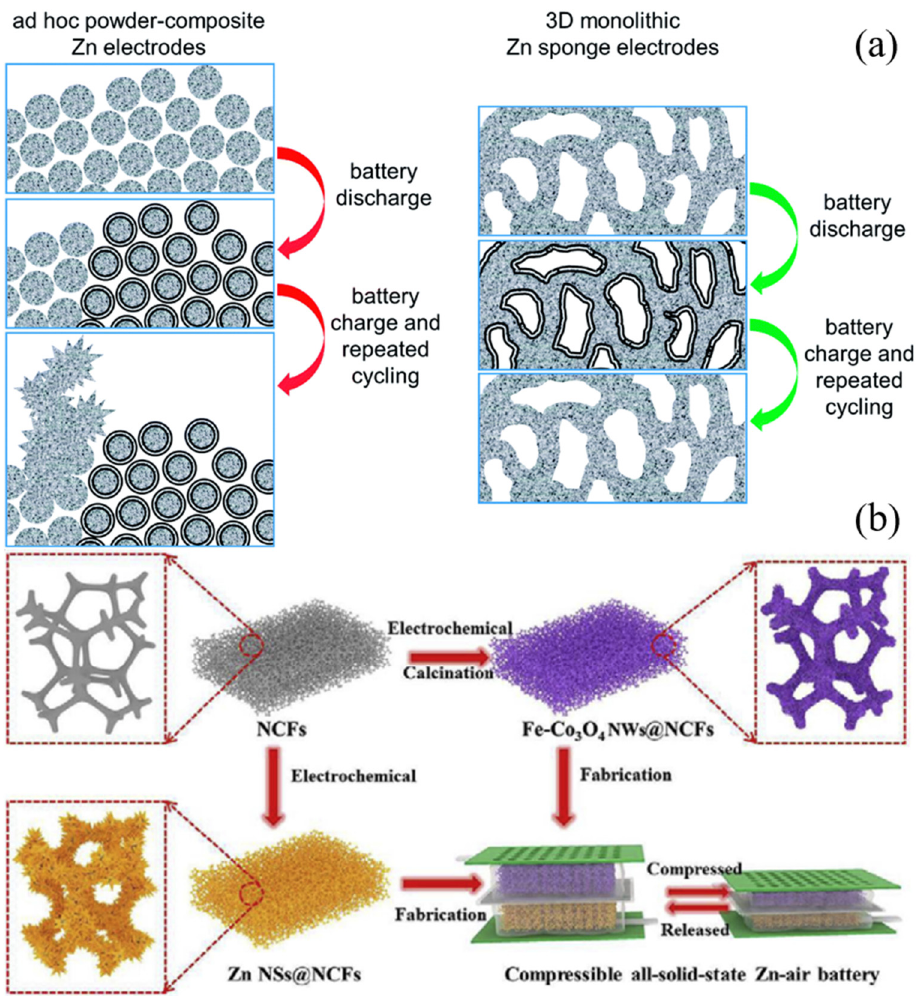
Figure 3. Graphic representation of ( a ) the zinc oxide dissolution and deposition traditional powder- composite zinc anode and the zinc wire (3D-sponge structured) anode [29], Reprinted with permission from Ref. [29], Copyright 2014, The Royal Society of Chemistry; and ( b ) fabrication method for the compressible and rechargeable solid-state zinc–air battery [28]. Reprinted with permission from Ref. [28], Copyright 2019, Elsevier.